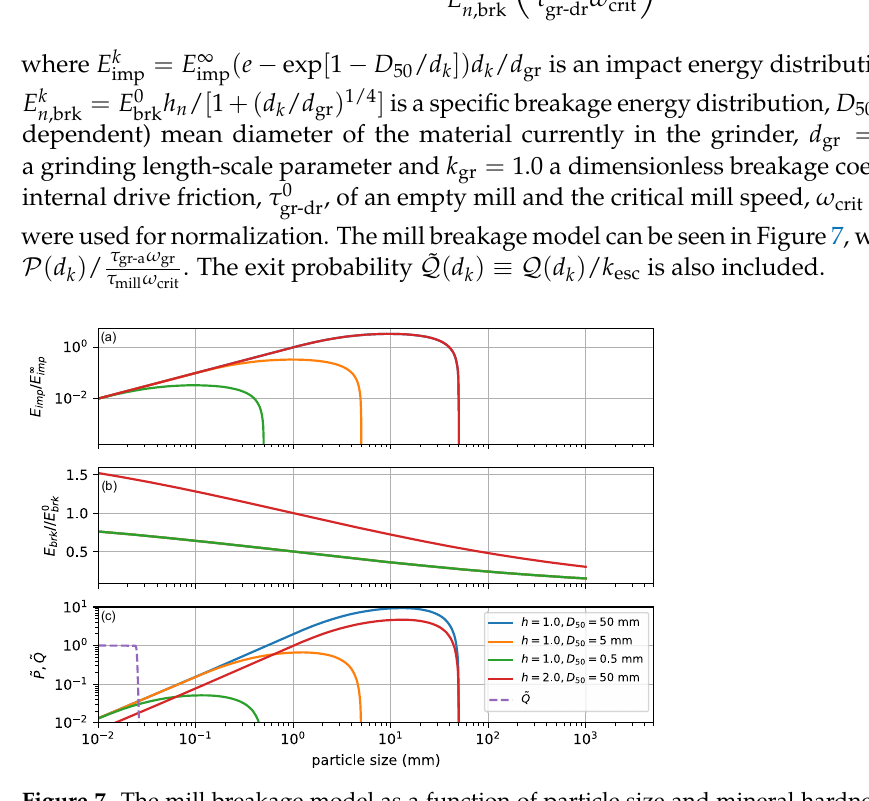
Figure 7. The mill breakage model as a function of particle size and mineral hardness illustrated in terms of the impact energy distribution ( a ), specific breakage energy ( b ) and the breakage proba- bility rate ( c ). The probability rate for exiting the mill is also